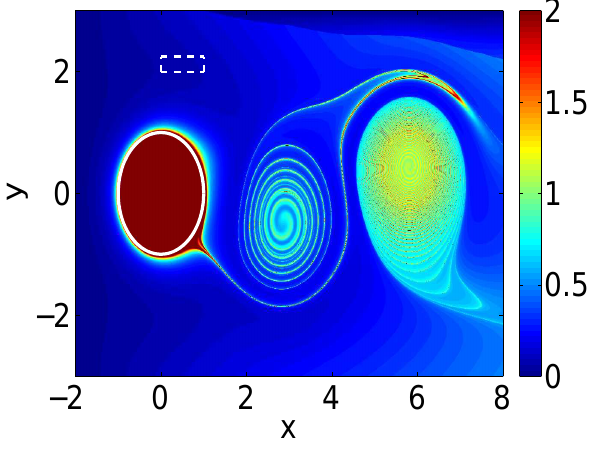
− res ( r ,t) of the T c − res ( r ,t ) of the flow field for t = 0 . 8 T c T c